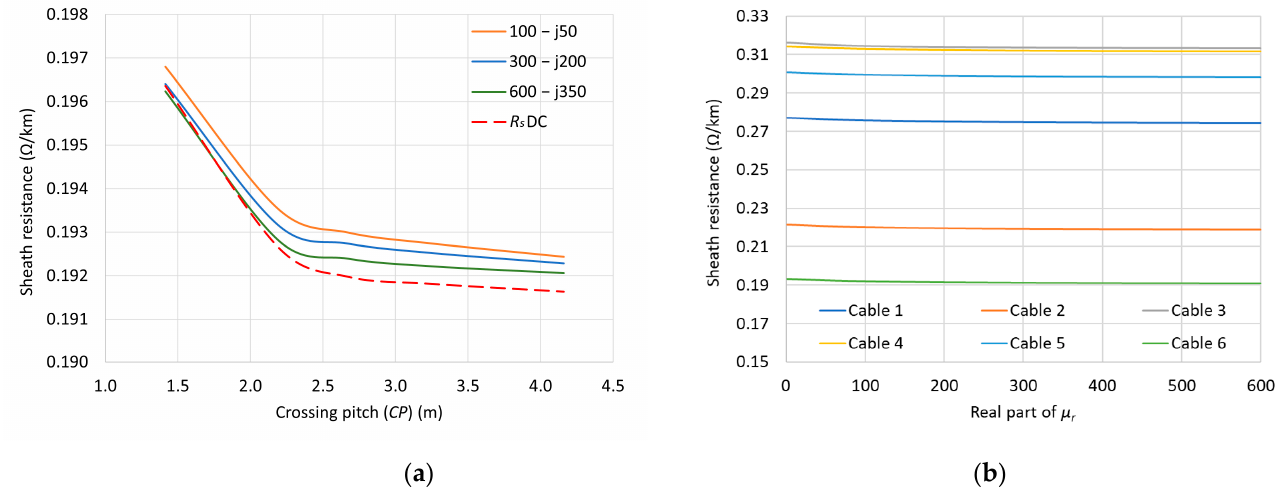
Figure 19. Variation of R s with ( a ) the CP for Cable 6 for different values of µ r and ( b ) the real part of µ r for the 6 cables considered (SB).